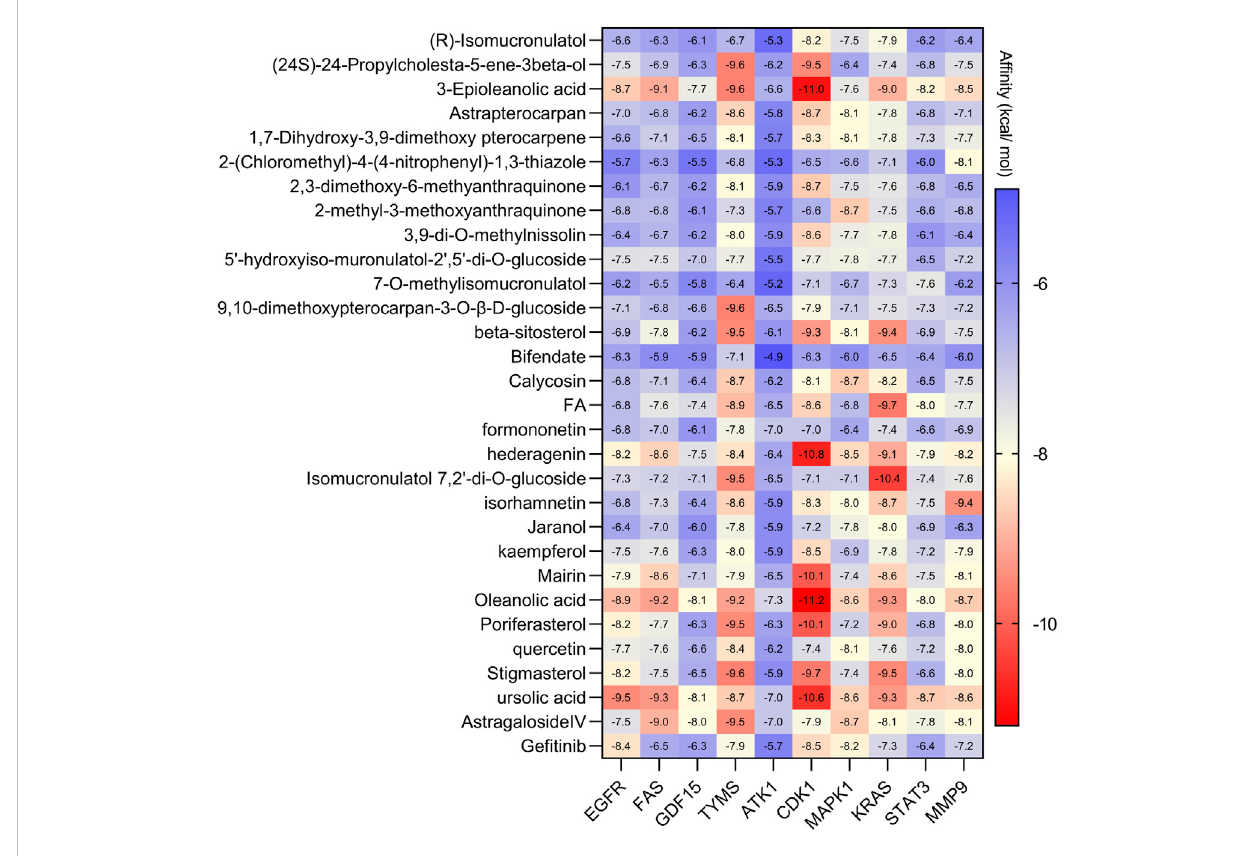
FIGURE 5 Docking results of active ingredients of AR-SH with core